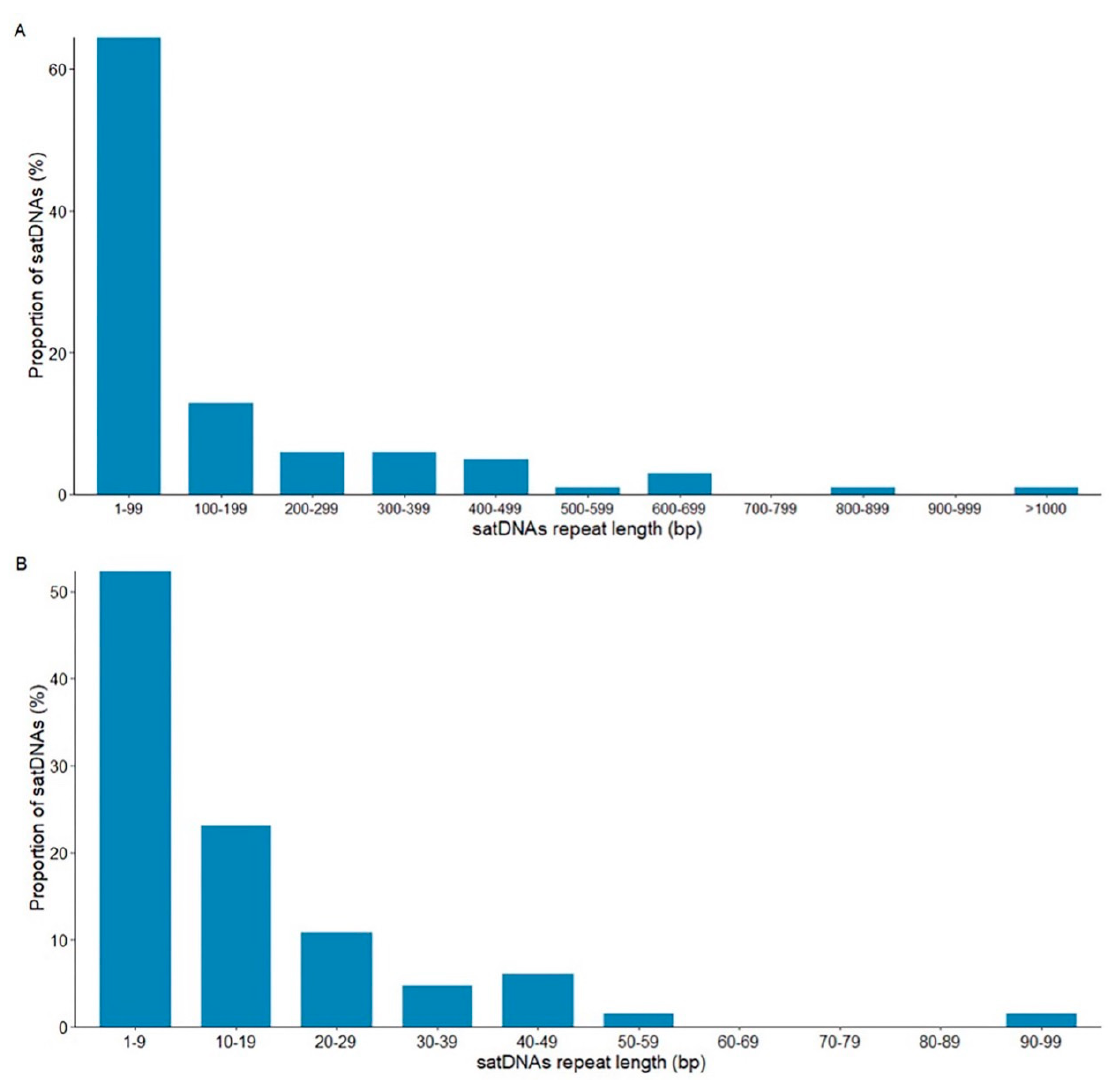
Figure 3. SatDNAs repeat length (monomer size) in the montium group. ( A ) The repeat length of all 101 satDNA families identified in the present work. ( B ) Repeat length of the 65 satDNA families featuring less than 100 bp long repeats.